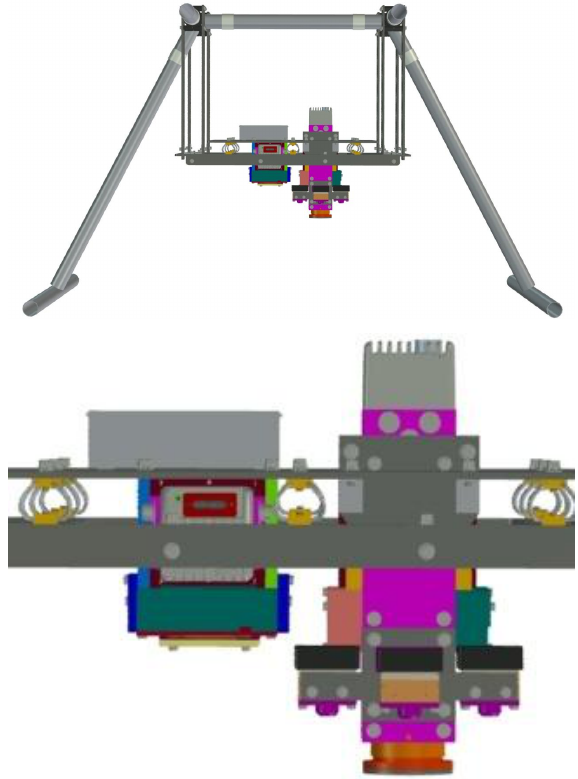
Figure 2 DroneKnowledge hyperspectral imaging system mounted to the drone.